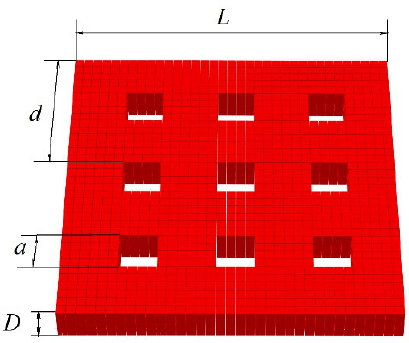
Figure 1. Systems Figure 1. Systems geometry.